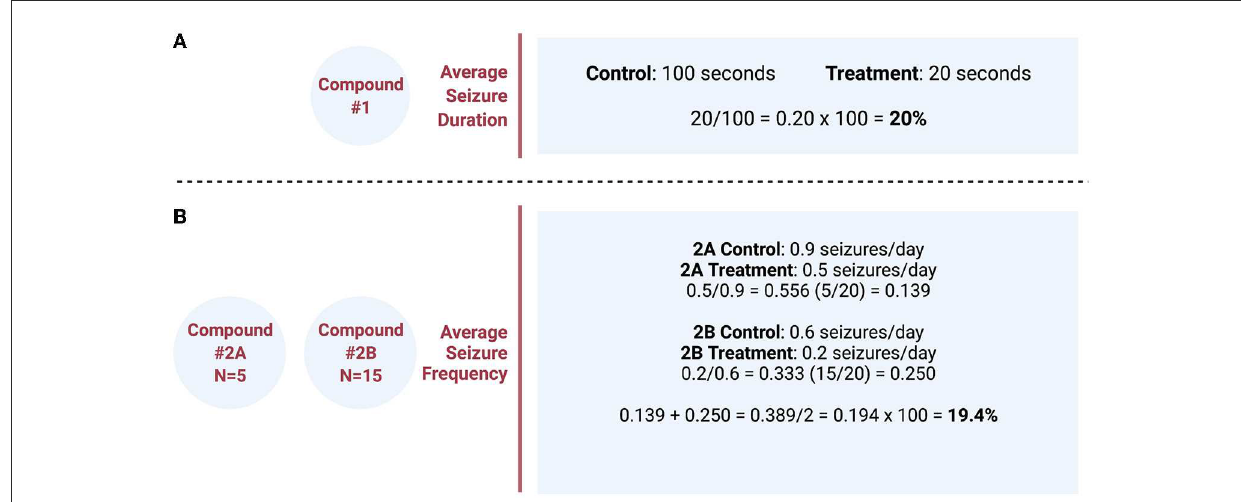
FIGURE2 (A) Simple example calculation of the quantitative analysis comparing the effect of each pharmacologic compound with respect to its own control. (B) Example calculation of two different studies, examining the same compound and dose, that combines the data and weights percentages based on the different sample size ( N ) of each study. These percentages were then plotted for comparison between different pharmacologic interventions grouped by the variable of interest.